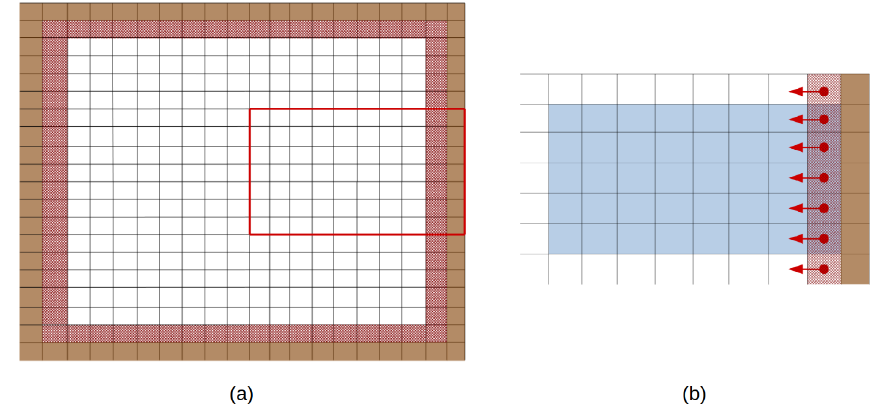
Figure 4. On the left, a configuration with straight open boundaries, the red line delimits a possible MPI subdomain detailed on the right. Brown cells are land cells and red hatched cells are open boundary cells. On the right, inner domain cells are in blue; red dots mark T points constituting the open boundary ( (x i ,y i ) ) and red arrows the points orthogonal to the boundary ( (x i − 1 ,y i ) ) used in the computing of ∂φ | (x,y) = (x i ,y i ) . ∂n